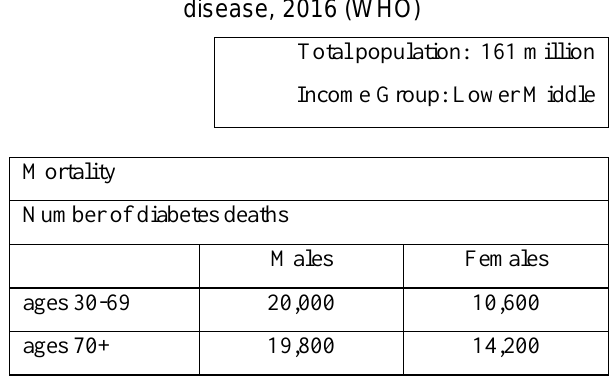
Table 2. Number of people dying for